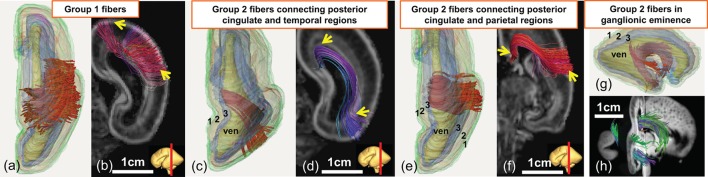
Demonstration of three-dimensionally reconstructed group1 or group2 neural fibers categorized based on the terminal locations in a 20 PMW fetal brain. Superior view of three-dimensionally reconstructed group1 fibers (red) with subdivided three layers is shown in (a). The corresponding group1 fibers displayed on top of a coronal slice of the FA map is shown in (b). Superior view (c, e) and lateral view (g) of different types of group2 fibers (red) with reconstructed segmented three layers as anatomical reference are shown in (c,e,g), respectively. The corresponding group2 fibers displayed on top of the coronal slices (d,f) of FA map and sagittal and coronal slice (h) of the aDWI image are also shown. See Figure 4 legend for the color scheme of three cerebral wall layers and abbreviation.